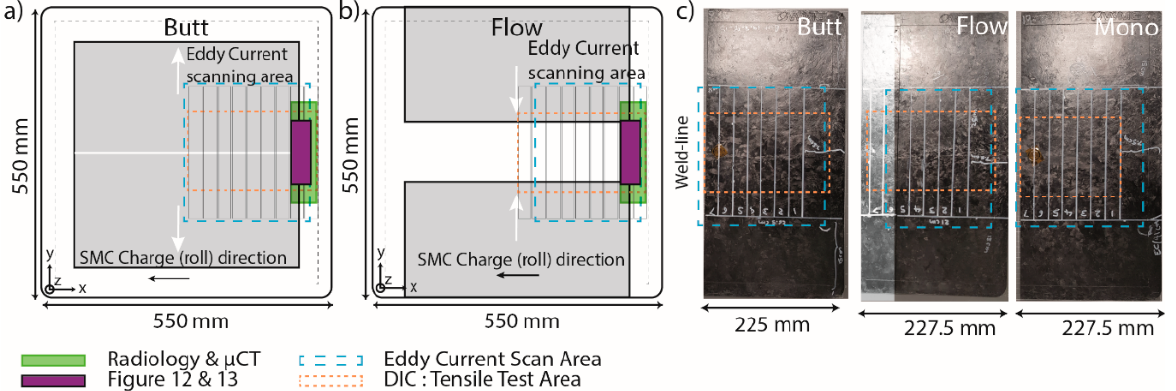
Figure 4. ( a , b ) DIC from tensile testing (dashed orange), eddy current (dashed blue), µ CT, and radiography (green box) area are shown for the Butt and Flow plaques. The green box highlights the location of µ CT and radiography. The purple box highlights the RoI from which all NDT and DIC images are compared; ( c ) DIC area is shown with a dashed orange line and the EC measurement with a dashed blue line on the actual three different plaques.